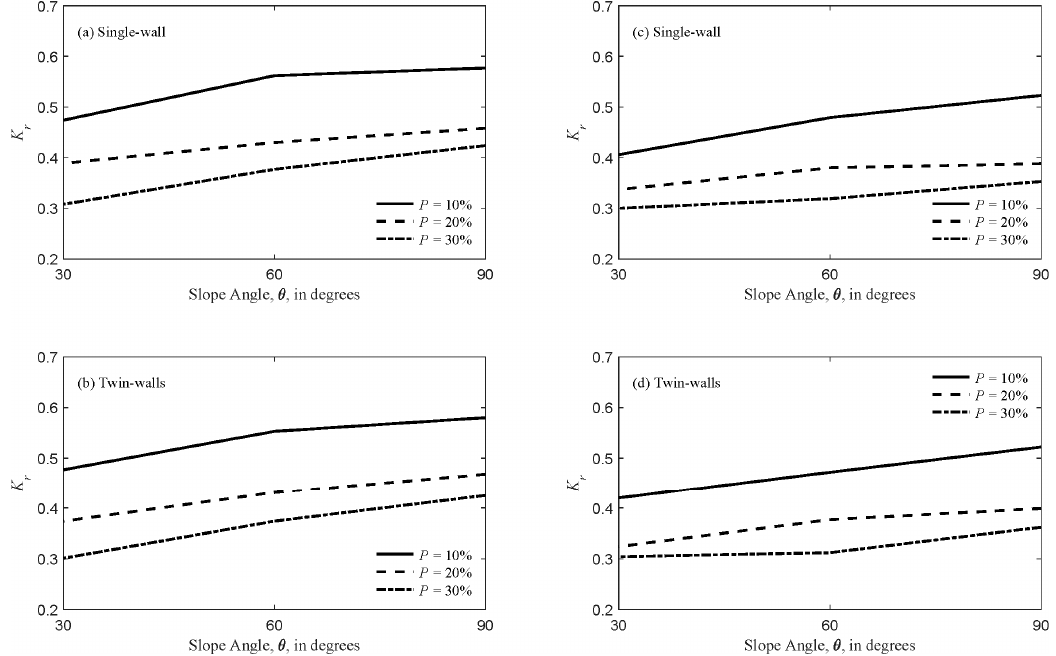
Figure 16. Variation of K r with θ for d / L p = 0.1529, and different porosities and wall configurations. On the left, H is / d = 0.2493 ( a and b ) and on the right H is / d = 0.1284 ( c and d ).